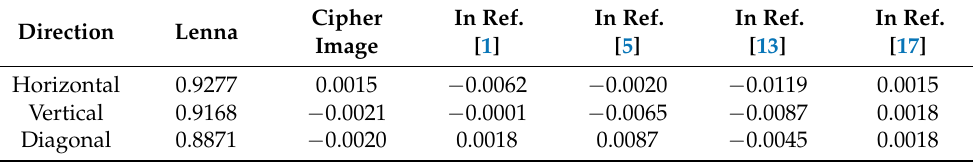
Table 4. Correlations